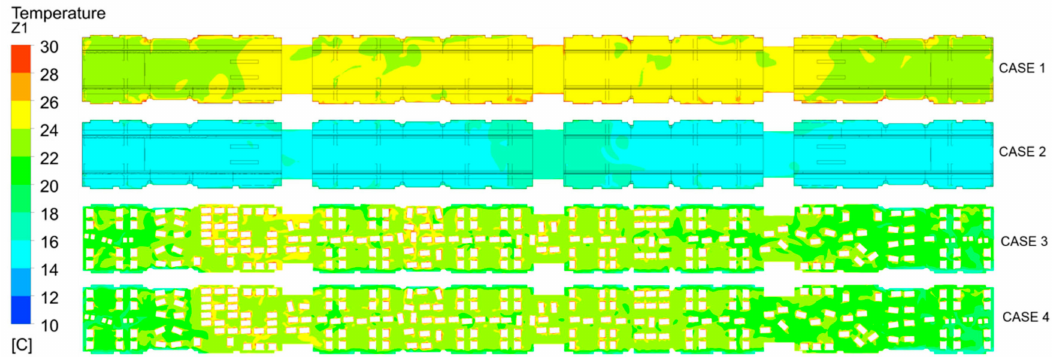
Figure 7. Temperature fields in the horizontal plane at +1.1 m, summer cases